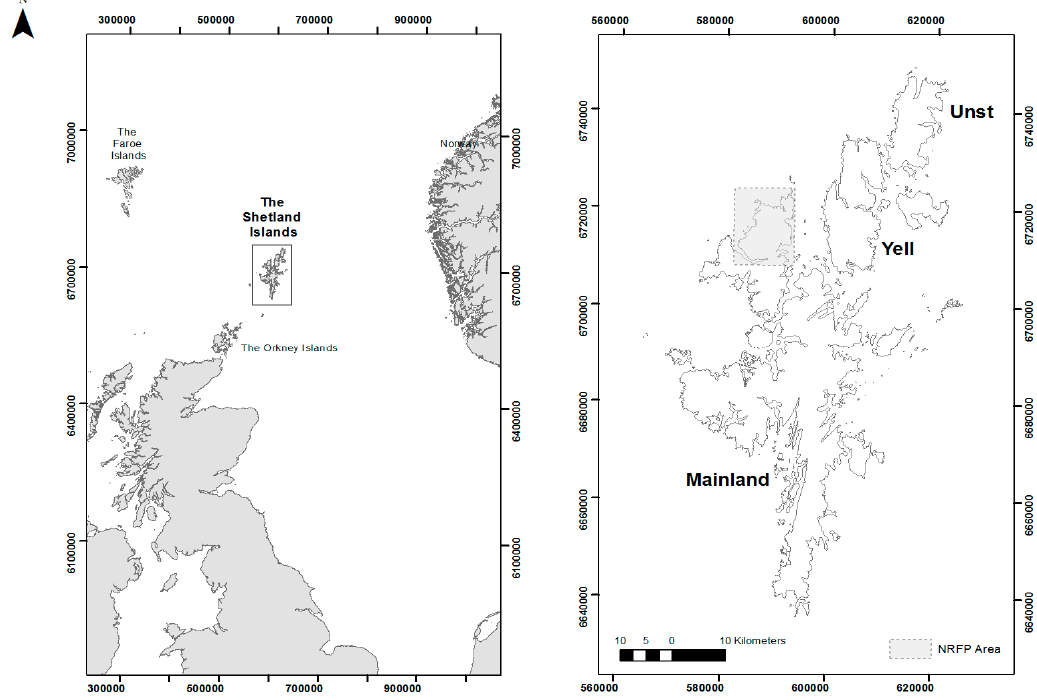
Figure 1. Northwestern Europe, the Shetland Islands and the North Roe Felsite Project (NRFP) Extent (Images by the Authors).